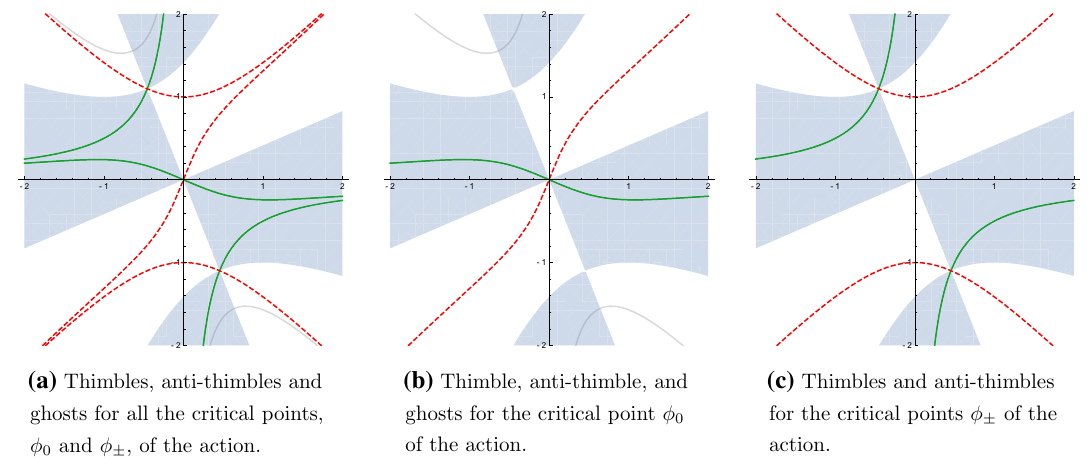
Fig. 2 The solutions to the thimble equation given in Eq. (3.3), cor- responding to the critical points φ 0 and φ ± , for the parameters { a = 1 , b = 1 , c = 1 , d = 0 , h = 0 } . In all the three figures, the green solid